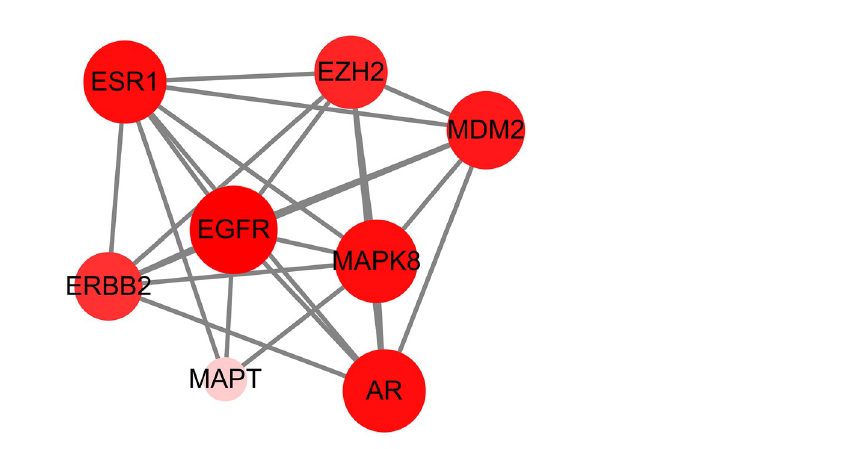
(Fig. 8) and related targets, including ErbB, ERBB2, EGFR, mitogen-activated protein kinase 8 (MAPK8) were revealed (Table 3), suggesting the importance of the targets of EGFR and MAPK8 ERBB and MAPK signaling pathways for VitD in its actions on COVID-19 and osteoporosis. From the GO and Rectome analysis(Table 4), the 8 common core targets involved in the innate immune system, cytokine signaling, GPCR signaling, vesicle- mediated transport, immune system and other signaling pathways were revealed (Supplementary Table S18–19), suggesting that the crosstalk between COVID-19 and osteoporosis by VitD may be through the regulation of